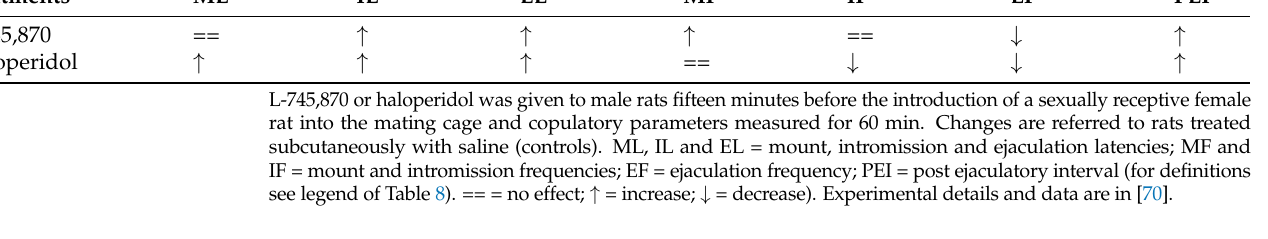
Table 10. Effect of the dopamine D 4 receptor antagonist L-745,870 on dopamine agonist-induced facilitation of copulatory behavior of sexually potent male